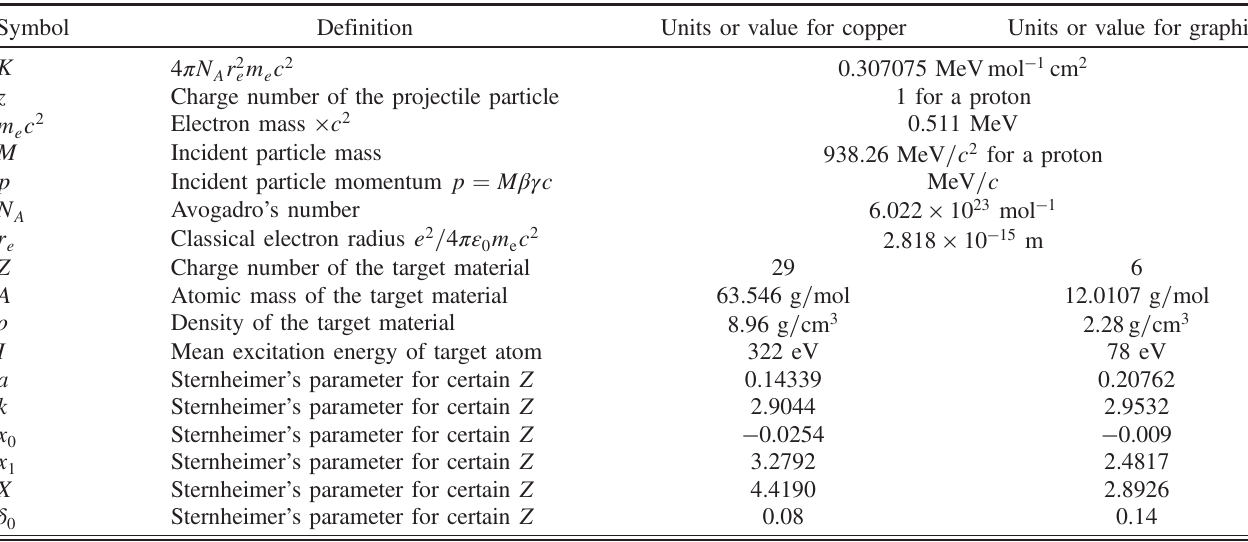
TABLE IV. Summary of the variables used in this paper. Symbol Definition Units or value for copper Units or value for